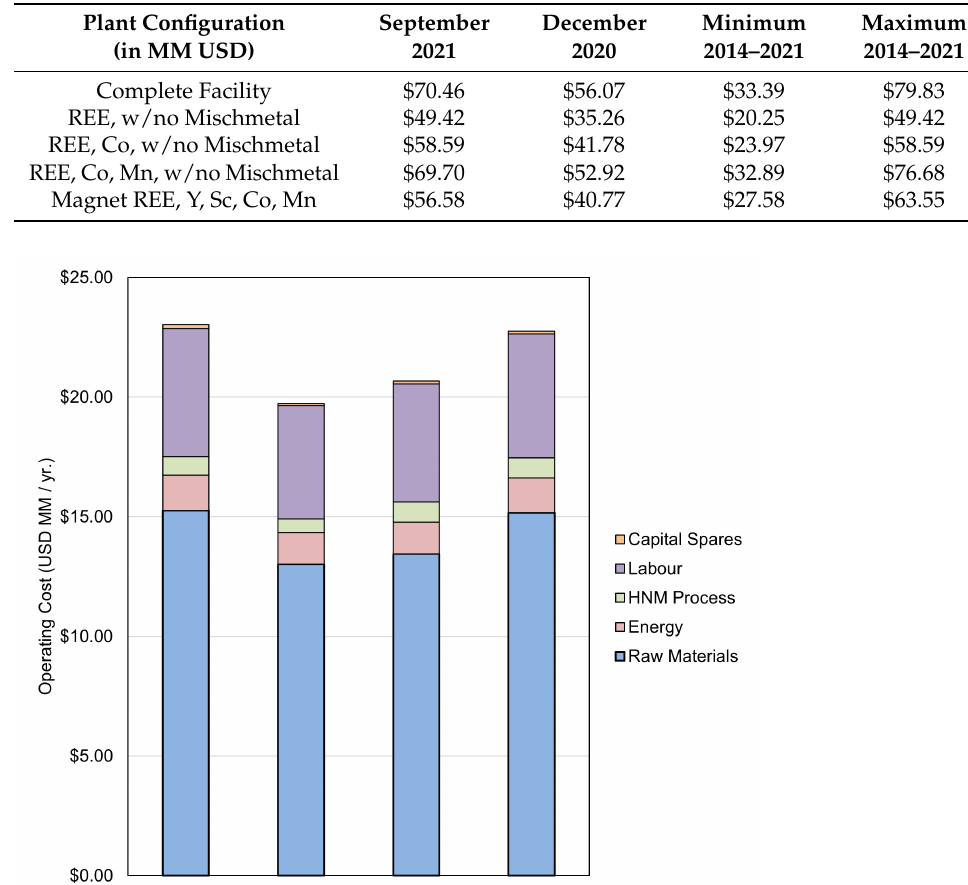
Table 8. Annual plant revenues for various operational configurations and pricing scenarios.